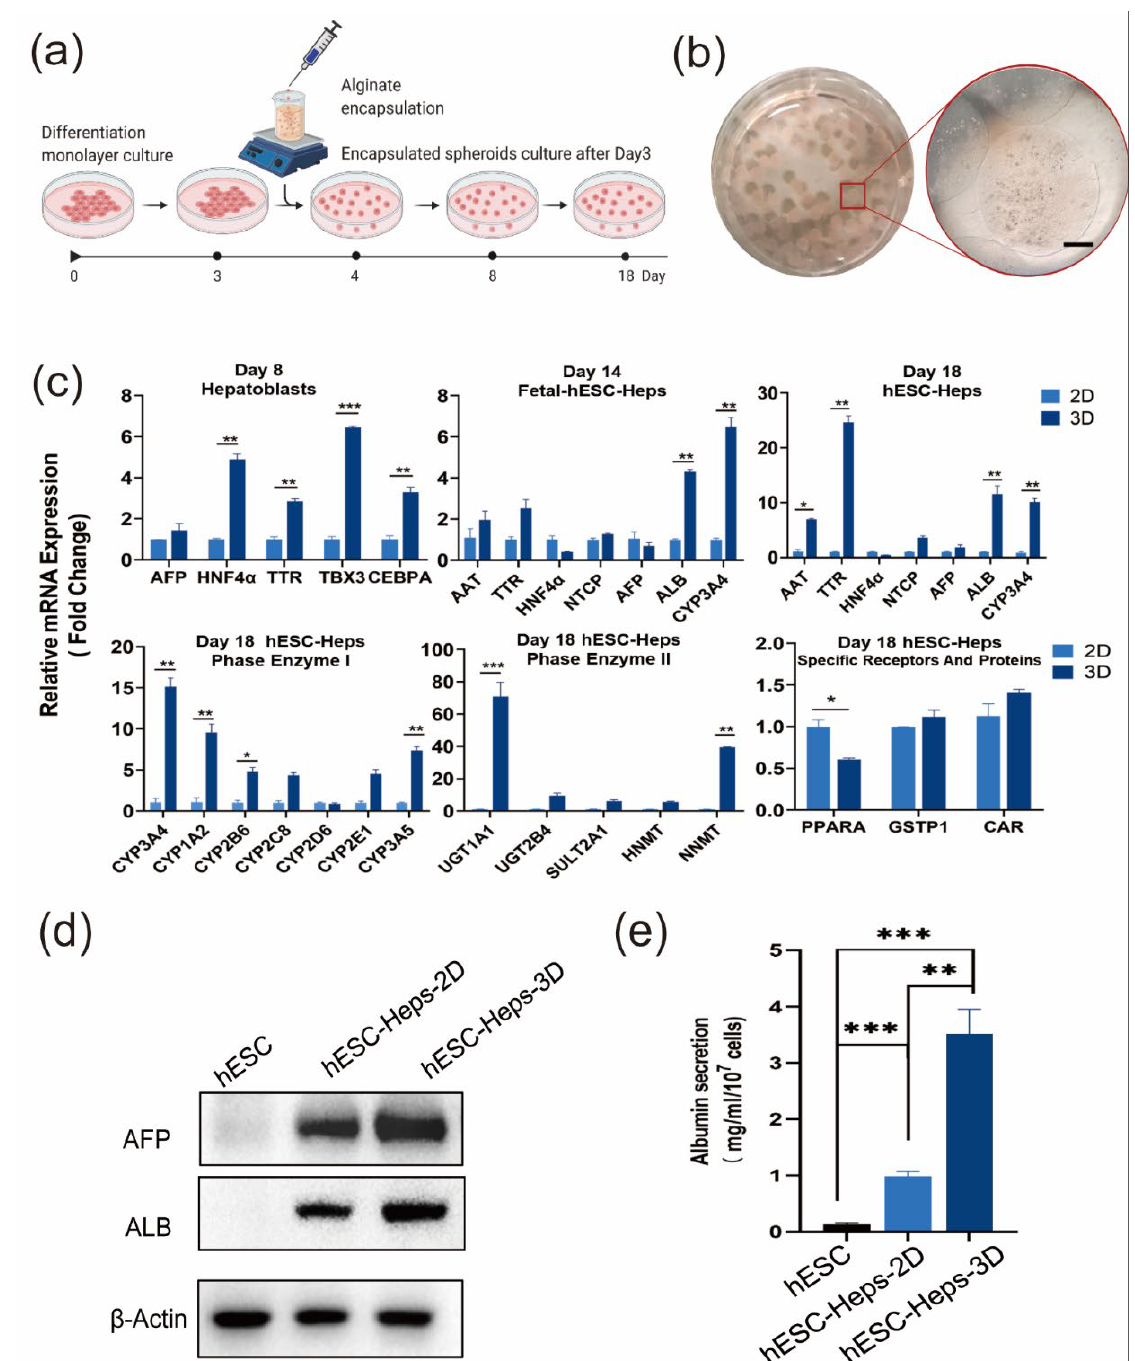
Figure 3. Differentiation and characteristics of hESC-Heps in 3D microsphere culture. ( a ) Schematic of the encapsulation and 3D cell-differentiation procedure. ( b ) Alginate microcapsules enclosing hESC-Heps (scale, 500 μm). ( c ) qRT-PCR for hepatocyte-specific markers on Days 8, 14, and 18, and expression of drug metabolizing enzymes and nuclear receptors of 3D hESC-Heps compared with 2D hESC-Heps. ( d ) Expression level of hepatocyte proteins in 3D hESC-Heps was compared with that of 2D hESC-Heps after induced differentiation for 18 days. ( e ) Albumin secretion of 2D hESC-Heps and hESC-Heps-3D was detected by a bromocresol green assay. Data are the mean ± SD (n = 3) and analyzed by Student’s t test. * p < 0.05, ** p < 0.01, *** p < 0.001.